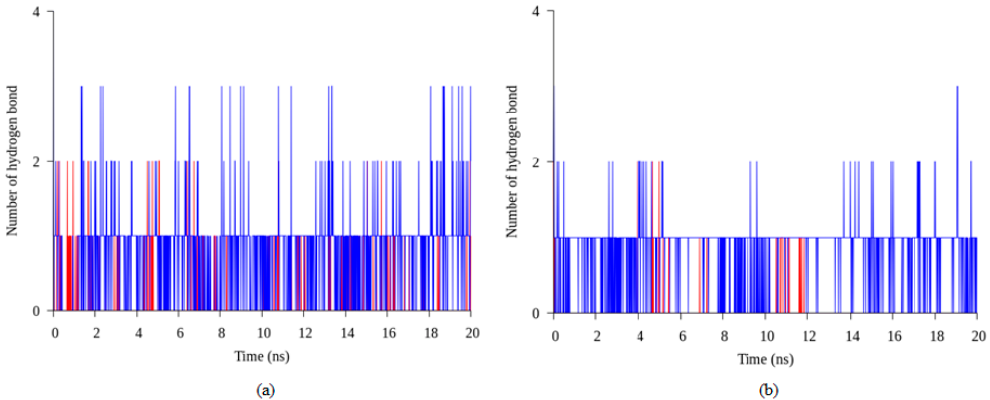
Figure 7. Interaction in earth-grown and space-grown T1 lipase structures: ( a ) Number of interaction between residue Arg230 and Glu226 in the space-grown (blue) and earth-grown (red) structures during 20 ns of simulation; ( b ) Number of interaction between residue Lys229 and Asp178 in the space-grown (blue) and earth-grown (red) structures during 20 ns of simulation.